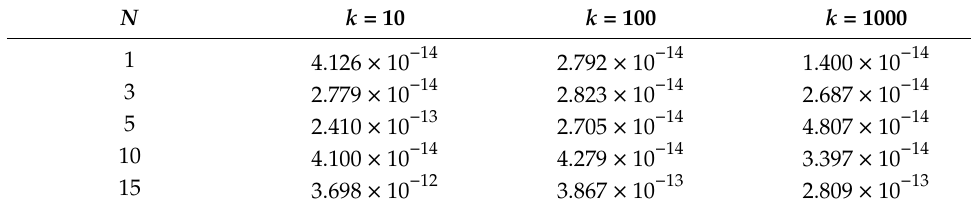
Table 2. The absolute error for B n ( x , k , α , β )